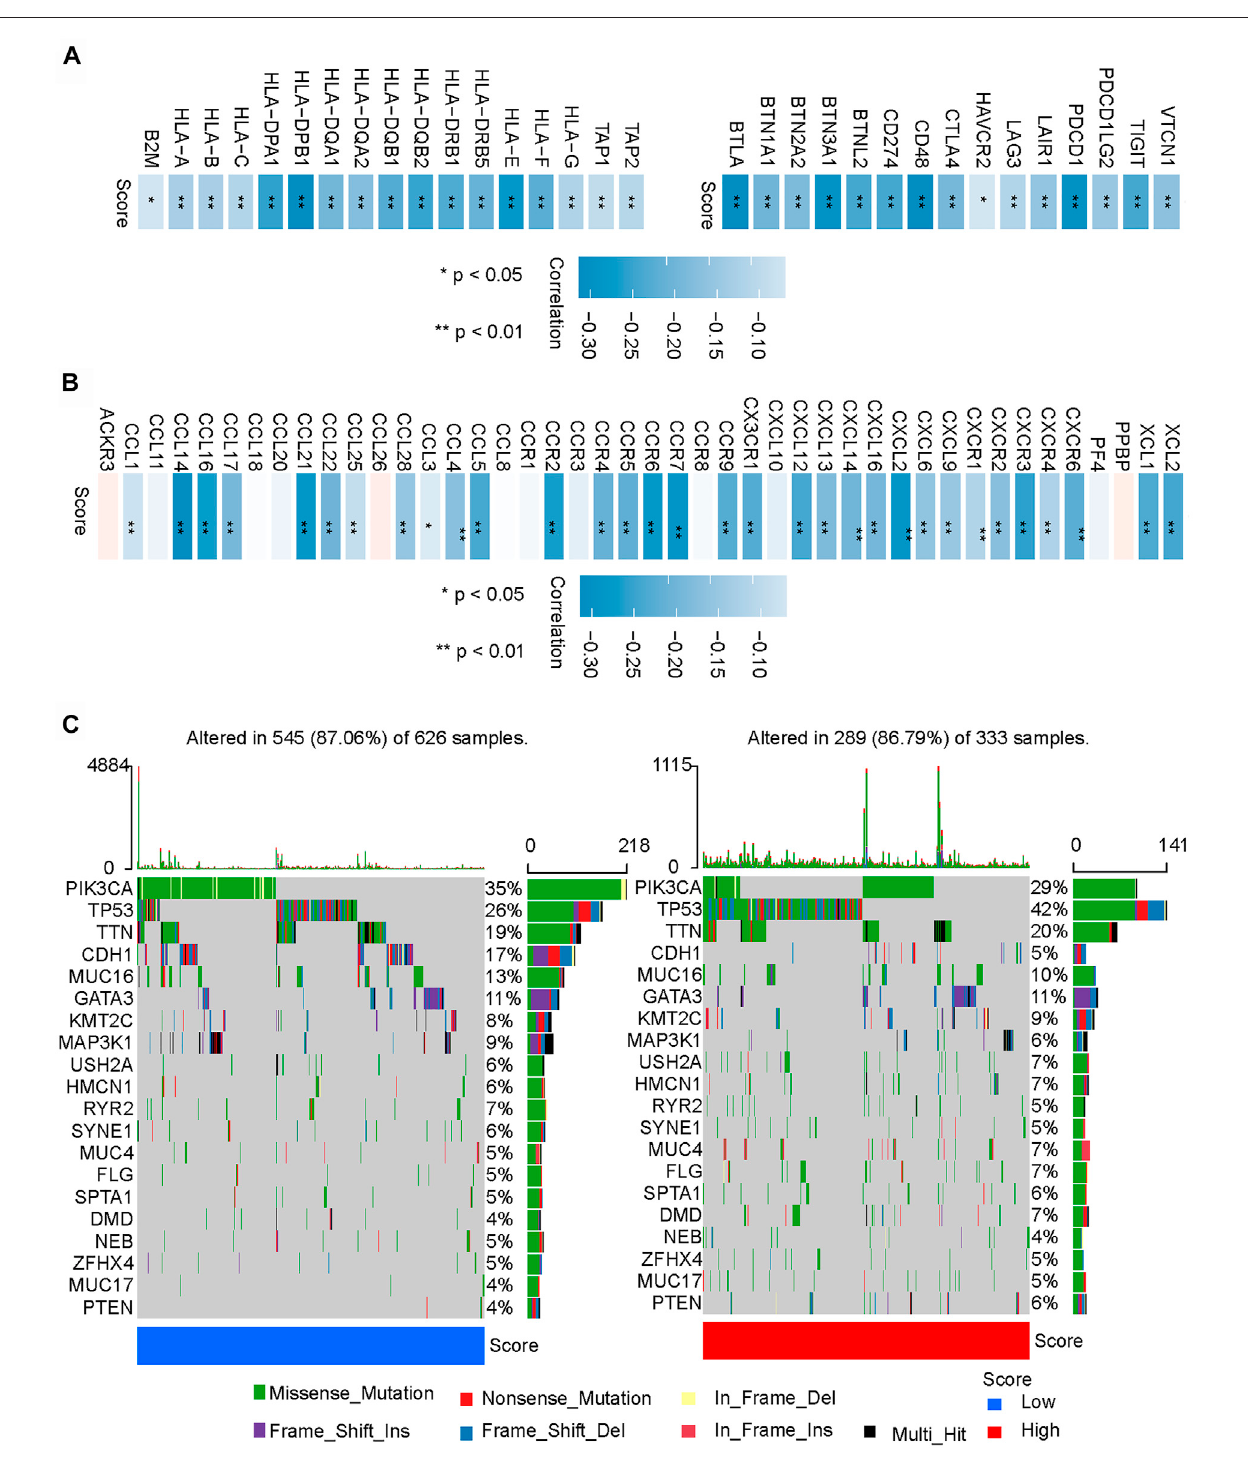
FIGURE 5 | Potential immune escape mechanisms in high and low N 6 -methyladenosine-related immune scores (m6A-IS). (A) Correlation analysis between the expressions ofMHC molecules and co-inhibitory molecules and m6A-IS (* p < 0.05; ** p < 0.01; *** p < 0.001). (B) Correlation analysis of the expressions of chemokines and m6A-IS (* p < 0.05; ** p < 0.01; *** p < 0.001). (C) Waterfall plot of tumor somatic mutations in the low- (left) and high-m6A-IS (right) groups. Individual patients are represented in each column. Missense mutation, green ; nonstop mutation, grey ; nonsense mutation, red ; multi-hit, black . The right bar plot shows the mutation frequency of each gene in separate